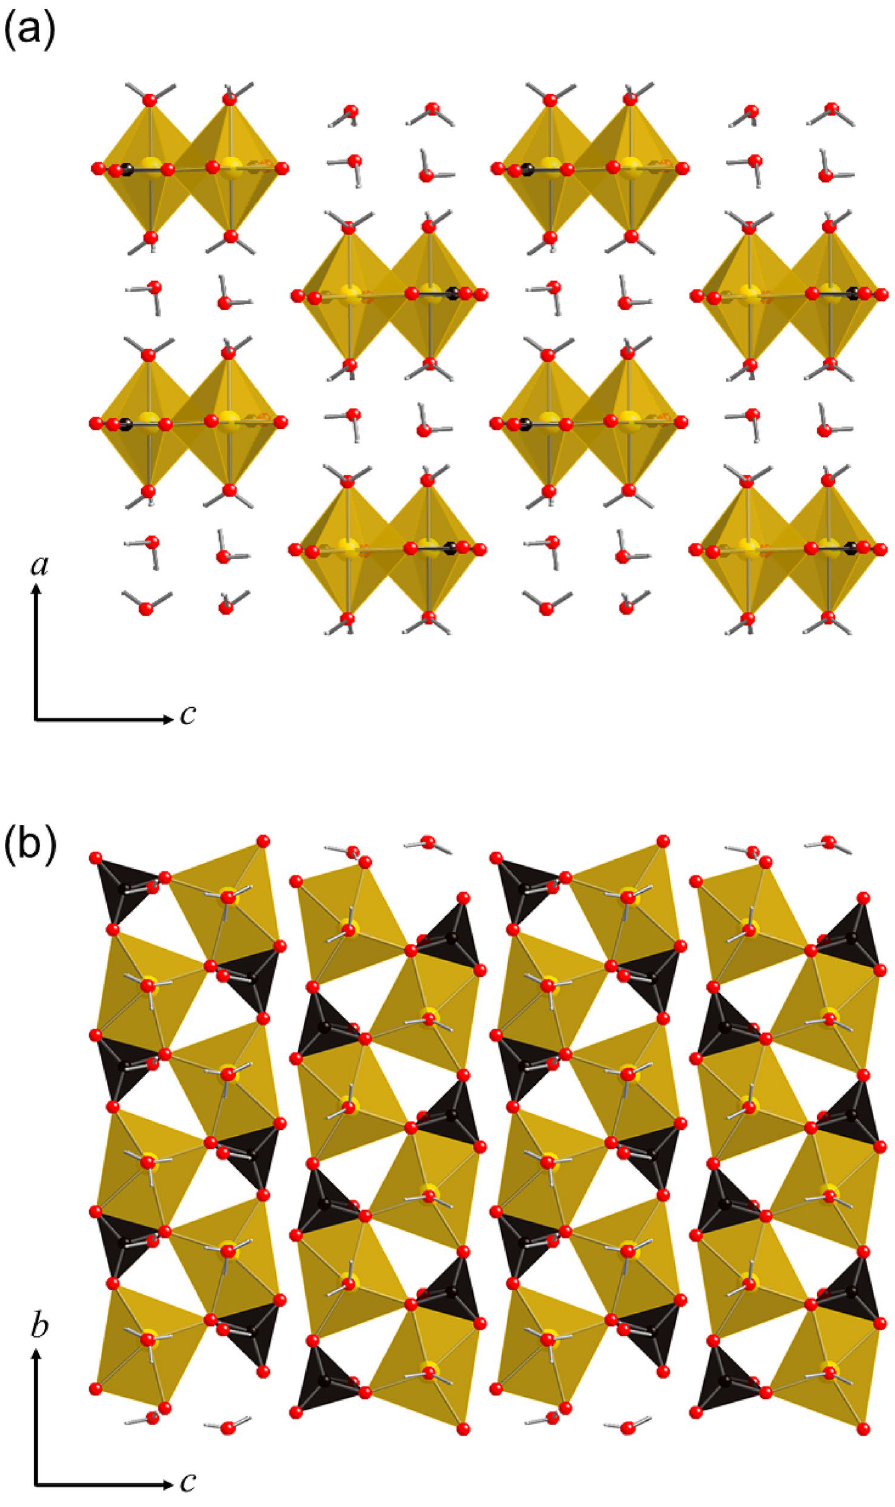
Figure 1. Crystal structure of nesquehonite (MgCO 3 ·3H 2 O) projected along the (a) b - and (b) a -axes 9 . Yellow polyhedra and black triangles represent MgO 6 octahedra and CO 3 groups, respectively. Red and small white spheres denote oxygen and hydrogen atoms, respectively. The crystal structure images were generated using CrystalMaker ®